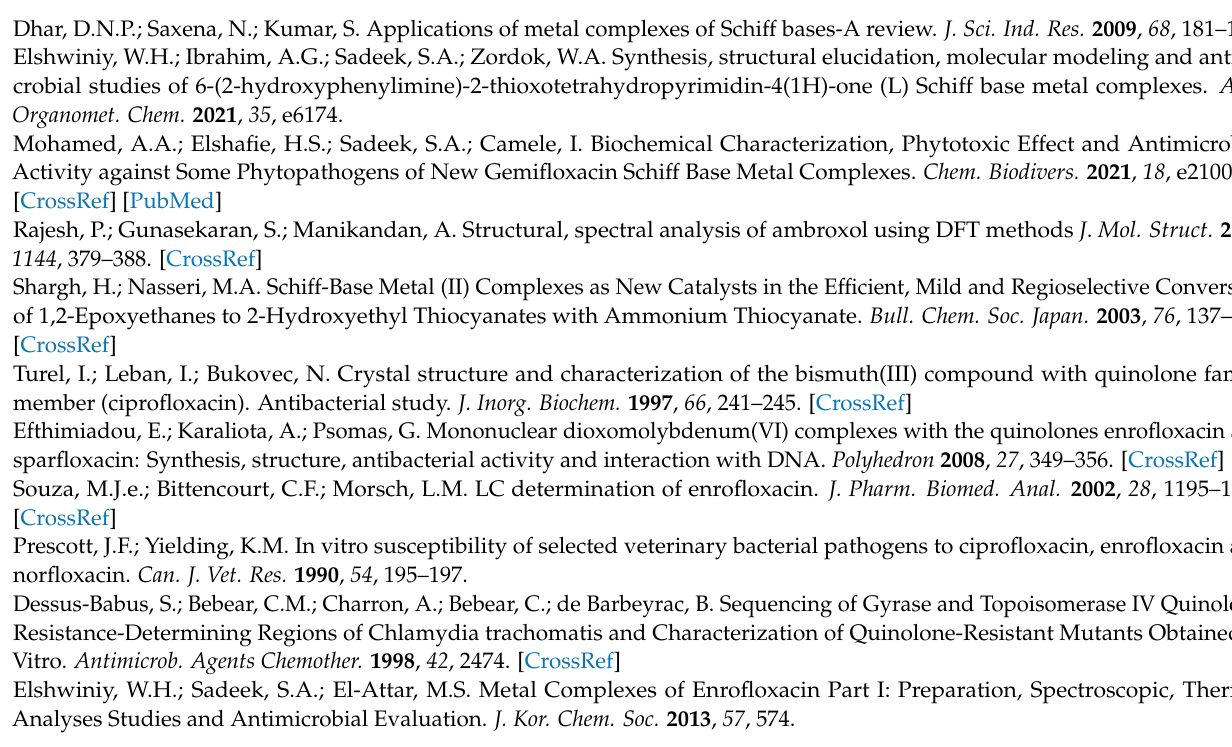
the manuscript. Figure S6. The diagrams of kinetic parameters of H2Erx-en and its metal complexes using Coats-Redfern(CR) and Horowitz-Metzger (HM)